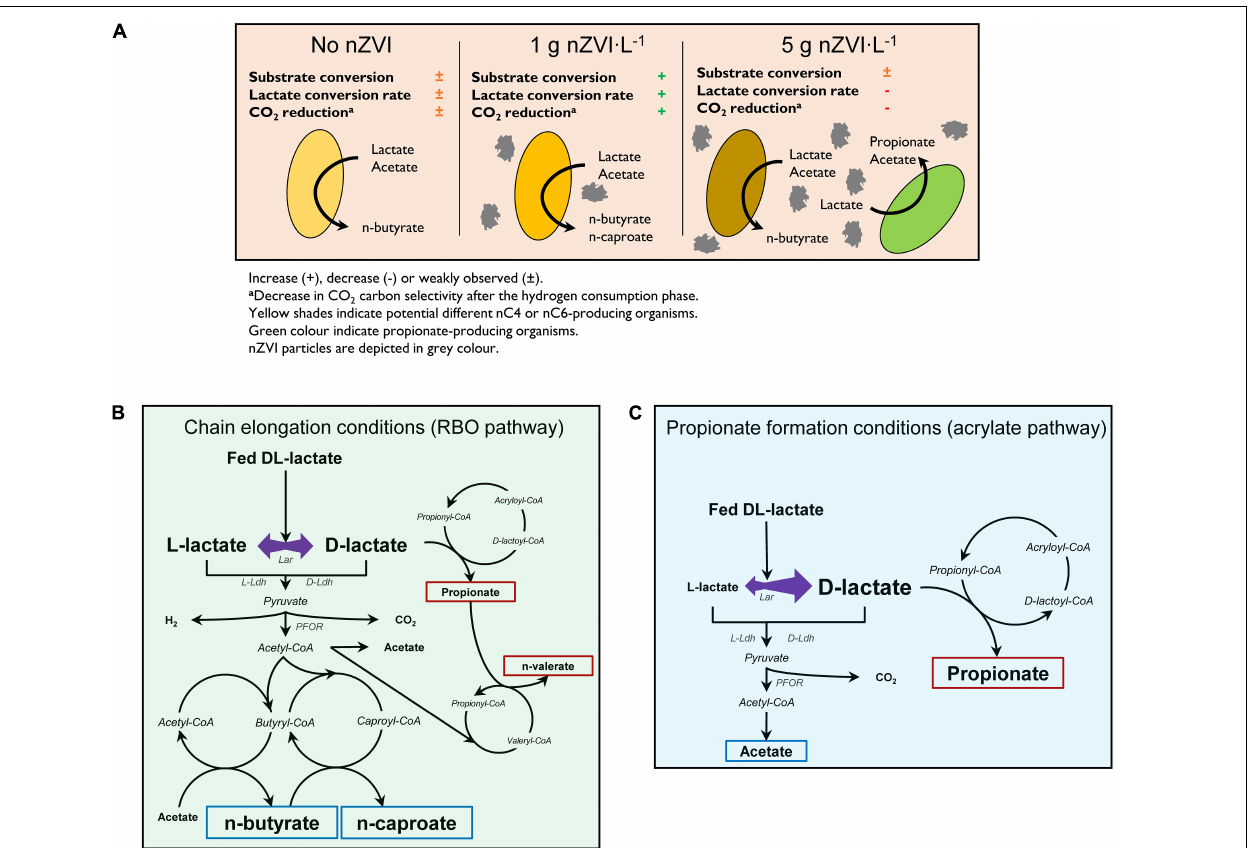
FIGURE 6 | Proposed effects of nZVI on lactate-based chain elongation (A) , enantiomeric proportions during lactate conversion to elongated carboxylates (B) and to propionate through the acrylate pathway (C) . Blue and red boxes depict even- and odd-chained carboxylates, respectively. Abbreviations: Lar, lactate racemase; D-Ldh, D-lactate dehydrogenase; L-Ldh, L-lactate dehydrogenase; PFOR, pyruvate:ferredoxin oxidoreductase. (B,C) Adapted from Schweiger and Buckel (1984); Kuchta and Abeles (1985), Hino and Kuroda (1993), and Angenent et al.